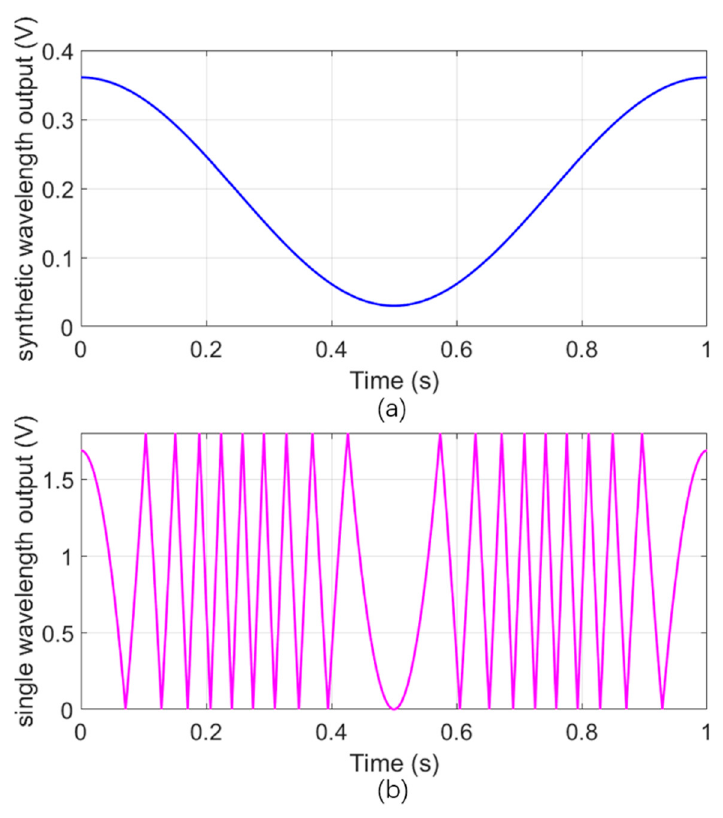
Figure 6. ( a ) Simulated synthetic wavelength output for the cosinoidal acceleration (displacement) in 1 s, in which the synthetic wavelength is set to 65.22 µ m, and the acceleration-displacement sensitivity is 76.06 µ m/g. ( b ) Simulated single wavelength output for the cosinoidal acceleration (displacement) in 1 s, in which the single wavelength is 632.8 nm.